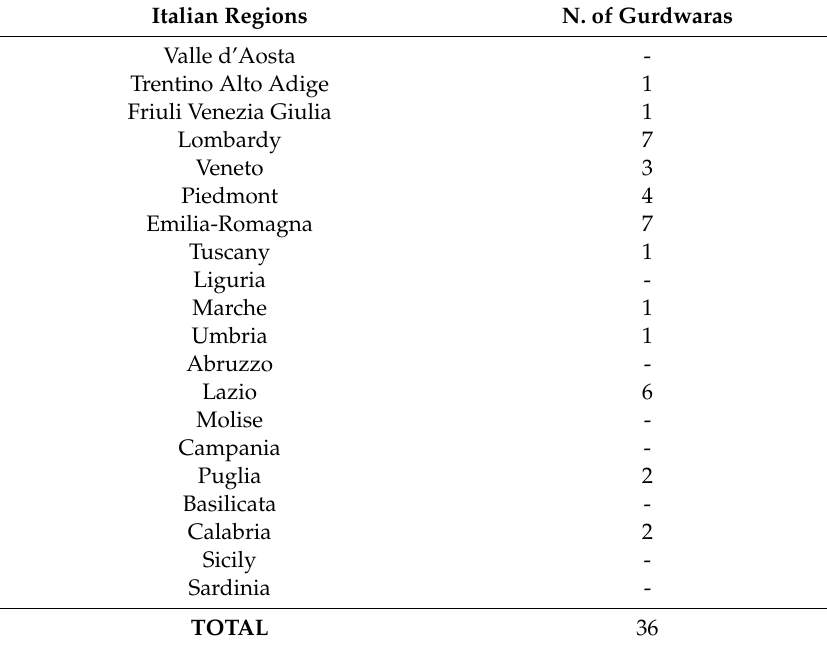
Table 2. Estimate of the number of gurdwaras in the various Italian regions. Italian